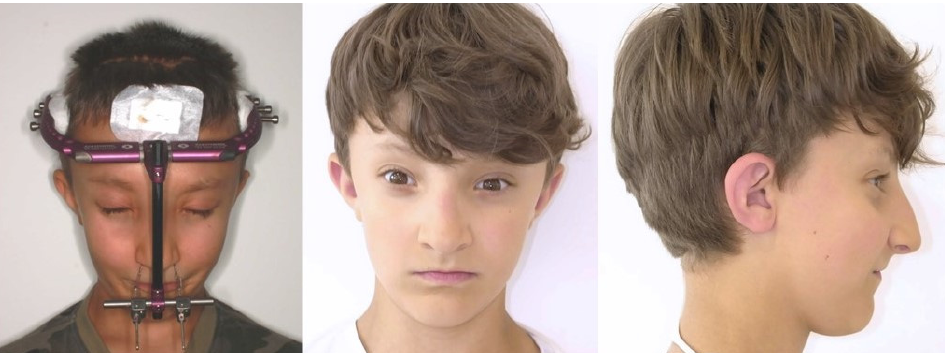
Figure 4. Midface distraction using RED distractors (left) and extraoral result immediately after distraction. To correct the temporary open bite, the distraction vector was adjusted caudally. As residual growth was expected, overcorrection of the midface advancement was performed .